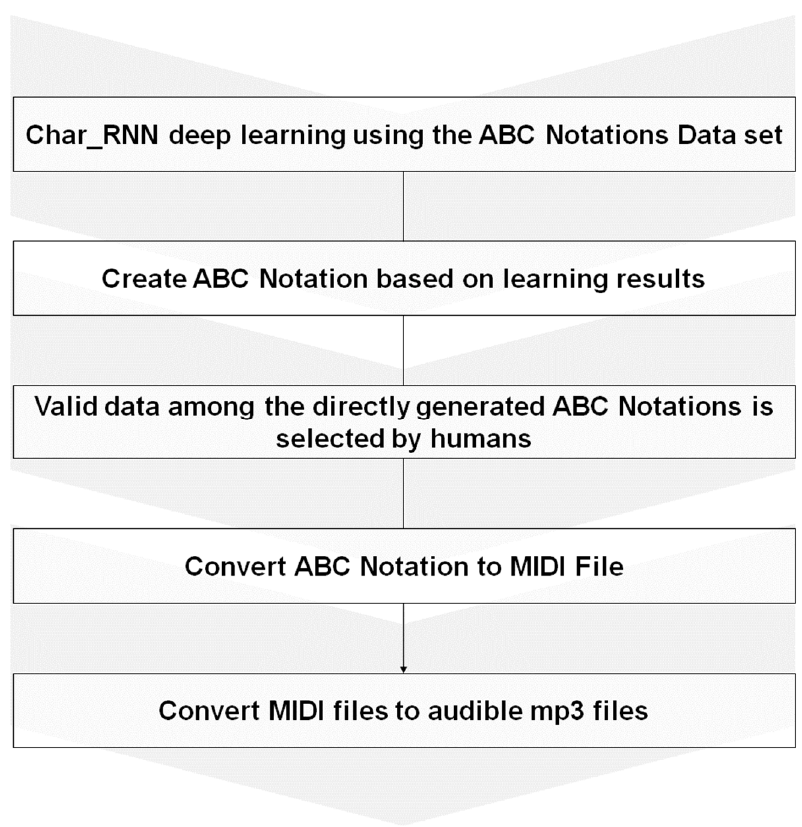
Figure 2. Deep learning process.